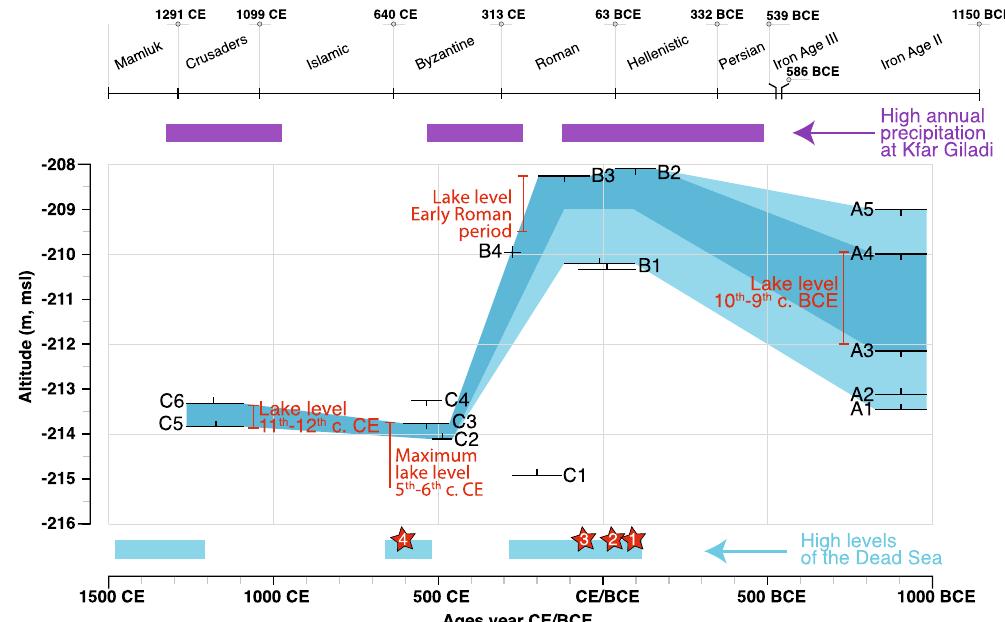
Figure 5. Sea of Galilee water level index points and lake level envelope. The red vertical bar indicates the position of the water (A1–A5 present the data from the breakwater/harbor basin at Kursi (A1 = base of the breackwater ; A2 = base of the harbor unit; A3 = top of the harbor unit; A4 = top of the breakwater at the time of excavation; A5 = estimated elevation of the breackwater in the Iron Age II); B1-B3 present the data from the harbor at Magdala 44 (B1 = bottom of the harbor basin; B2 = Late-Hellenistic mooring stone; B3 = Early Roman mooring stone; B4 = Late Roman landing zone); C1-C6 present the data from the fishpond at Kursi (C1 = locus 28011; C2 = cork; C3 = circulation surface; C4 and C6 = structure elevation ; C5 = infilling dated from the crusader period). The indicators show high lake level during the Iron Age II and the Late Hellenistic/ Early Roman period (between -208 and -210 m msl) and low lake levels during the Byzantine, Early Islamic and Crusader periods (<-213 m msl). Reconstructed high precipitation at Kfar Giladi (>600 mm/year) from Morin et al. 33 and high Dead Sea levels (>-402 m msl, corresponding to the sill elevation) from Kushnir and Stein 32 . Red stars represent specific high-water level of the Dead Sea reported from ancient authors or maps by Binder et al. 31